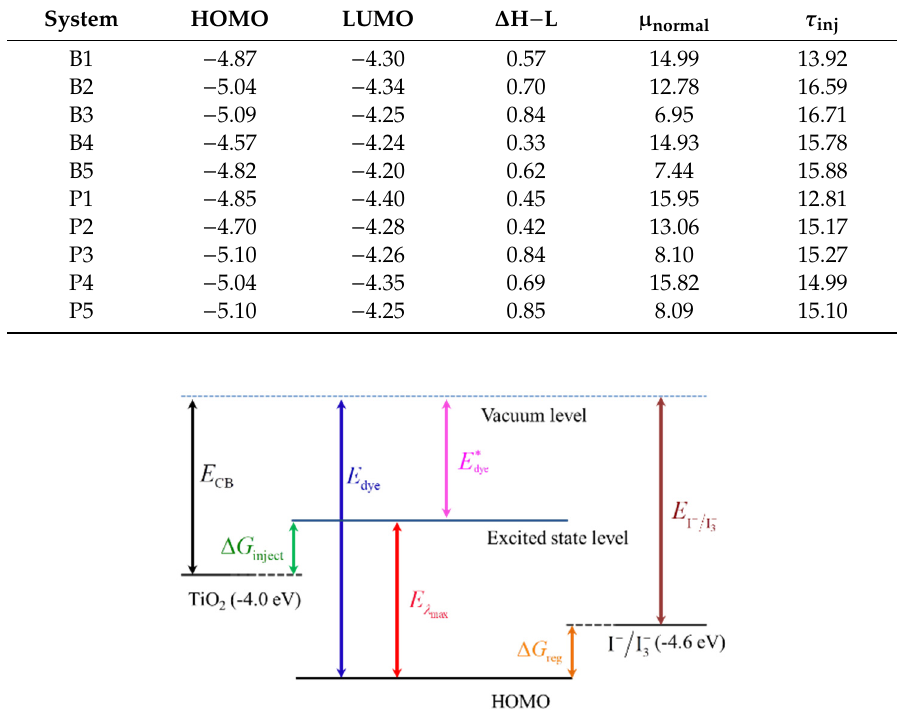
Figure 6. Energy level alignment of a dye-sensitized solar cell [47].